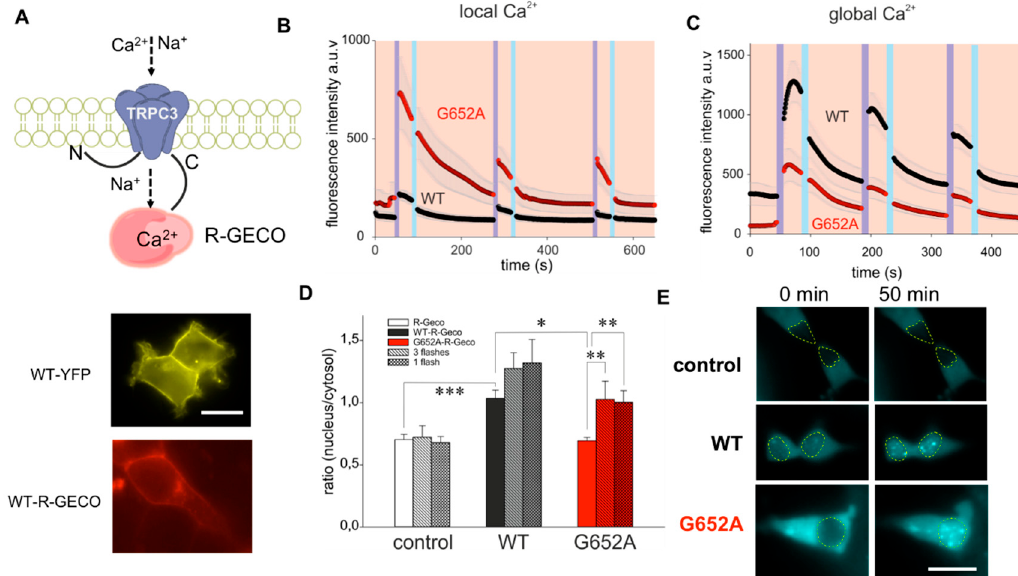
Figure 2. All-optical recording of TRPC3 Ca 2+ signaling signatures suggests coupling between bulk cytosolic Ca 2+ changes and NFAT1 activity. ( A ) Upper panel: Schematic presentation of TRPC3 C-terminal fusion with genetically encoded Ca 2+ sensor (R-GECO). Lower panel: Fluorescence images of WT-YFP and WT-R-GECO fusions. Local ( B ) and global ( C ) OptoBI-1 (10 μ M) photocycling-induced Ca 2+ changes in HEK293 cells expressing WT-R-GECO and G652A-R-GECO (local) or WT-YFP and G652A-YFP with R-GECO (global), respectively. Time courses (mean ± SEM) of R-GECO fluorescent intensity during photoactivation of WT (white, WT-R-GECO: n = 15 cells; WT-YFP: n = 15 cells) and G652A (red trace, G652A-R-GECO: n = 20 cells; G652A-YFP: n = 15 cells). Cis-trans OptoBI-1 photoisomerization was repeated three times illuminating with UV (365 nm, 10 sec; violet) and blue light (430 nm, 10 sec; blue). ( D ) NFAT1 nuclear translocation in HEK293 cells overexpressing only CFP-NFAT1 and R-GECO (control; n = 11), WT–R-GECO (WT; black / grey, n = 11) or G652A–R-GECO (G652; red, n = 12). Mean ± SEM nucleus / cytosol fluorescence intensity ratio. CFP-NFAT1 translocation was monitored during OptoBI-1 photoconversion, with either three (3 Flashes) or one (1 Flash) photocycles of illumination as indicated. Statistical significance was tested by One-Way ANOVA (Holm-Sidak test for normally distributed values) or One-Way ANOVA for Ranks (Dunn’s test for non-normally distributed values), * p < 0.05, ** p < 0.01, *** p < 0.001, if not indicated – not significant ( p > 0.05); ( E ) Images of NFAT1 translocation in HEK293 cells expressing CFP-NFAT1 only (control; upper panel) or co-expressing CFP-NFAT1 plus WT–R-GECO (WT; middle panel) or G652A–R-GECO (G652A; lower panel) before (0 min) and after (50 min) three cycles of UV (365 nm, 10 sec) and blue light (430 nm, 10 sec) illuminations. Nuclear regions are indicated. Scale bar represents 5 μ m.